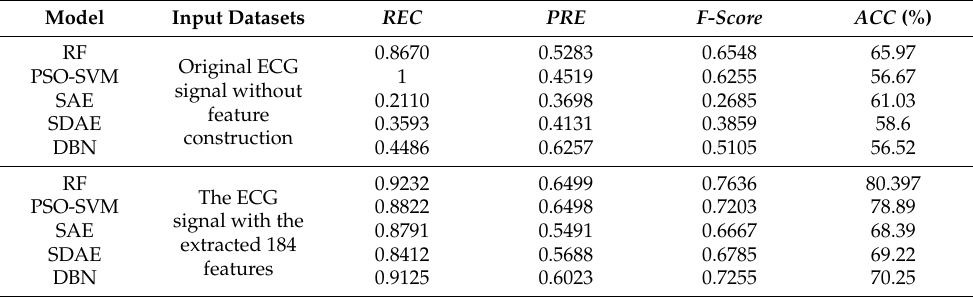
Table 6. The performance results of different models through cross